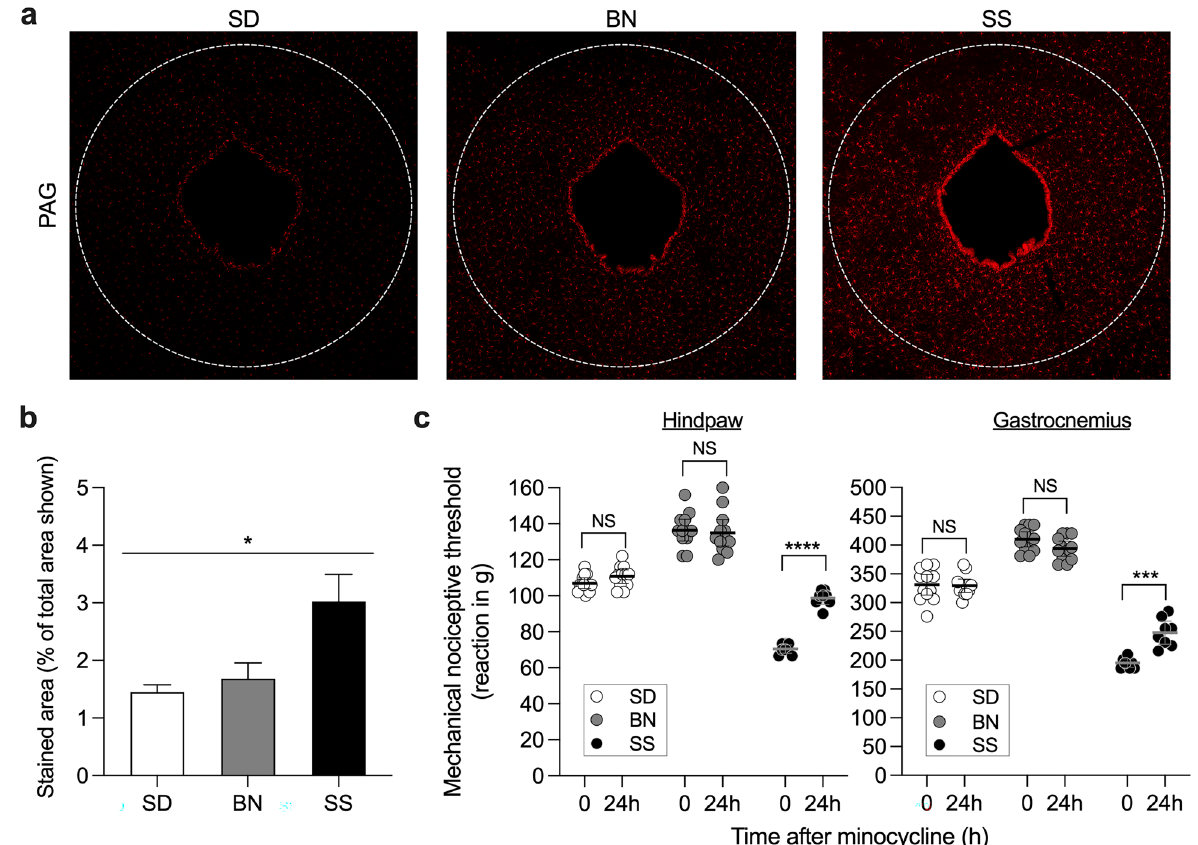
Figure 3. Inhibition of glial cells attenuates the hyperalgesic phenotype in SS rats. ( a ): Naïve SD (left image), BN (center image) and SS (right image) rats had their PAG collected and prepared for immunohistochemistry. Sections were stained with the glial cell activation marker Iba. Quantification of the staining ( b ) showed significant difference in active glial cells across the strains (F (2,6) = 6.883, * p = 0.0280), with higher intensity in sections from SS rats compared to SD ( p = 0.0277) and BN ( p = 0.0326) sections (one-way ANOVA followed by Bonferroni posttest). ( c ): SD (open circles), BN (gray circles) and SS (closed circles) rats received an i.p. injection of the glial cell inhibitor minocycline (30 mg/kg). Evaluation of the mechanical nociceptive thresholds, by the Randall-Selitto test, was performed on the dorsum of the hindpaw (left panel) or on the gastrocnemius muscle (right panel), before and 24 h after the injections. We observed a significant difference in the minocycline effect across the groups (F (2,29) = 152.4 for the hindpaw; F (2,29) = 367.8 for the gastrocnemius, p < 0.0001 for both when the three groups were compared, two-way repeated measures ANOVA followed by Bonferroni posttest), with increase in the nociceptive threshold in the SS rats (hindpaw: **** p < 0.0001; gastrocnemius: *** p = 0.0001), but no significant change in the SD (hindpaw: p = 0.3042; gastrocnemius: p > 0.9999, NS) or BN (hindpaw: p > 0.9999; gastrocnemius: p = 0.2395, NS) groups. Together, these findings suggest a role for glial cells in the SS rat hyperalgesic phenotype. ( c ): SS, n = 8; SD, n = 12; BN, n =